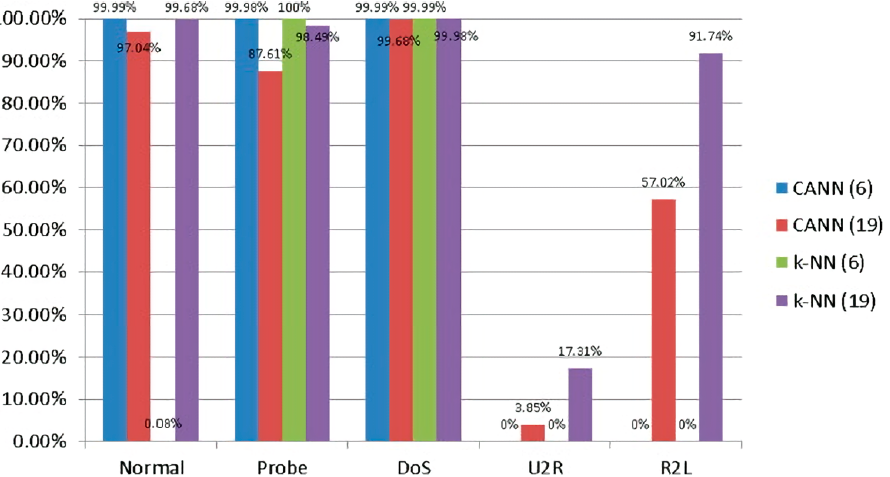
Figure 2. The performance of cluster center and nearest neighbor (CANN) and k-NN over 5 classes.